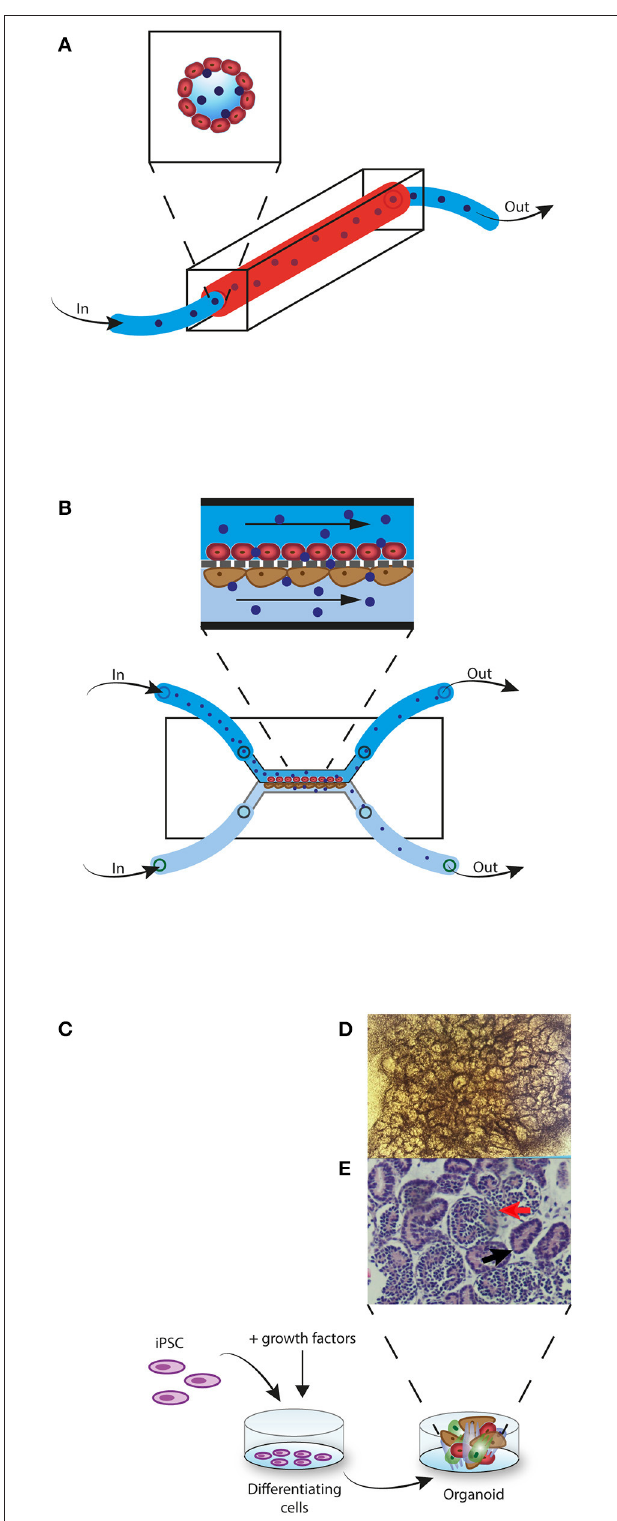
FIGURE 2 | 3D in vitro models. (A) Vessel-on-a-chip model. EC (red) are perfused through a PDMS mold channel. When confluent, alloreactive lymphocytes (blue) are perfused through the vessel. (B) Glomerulus-on-a-chip